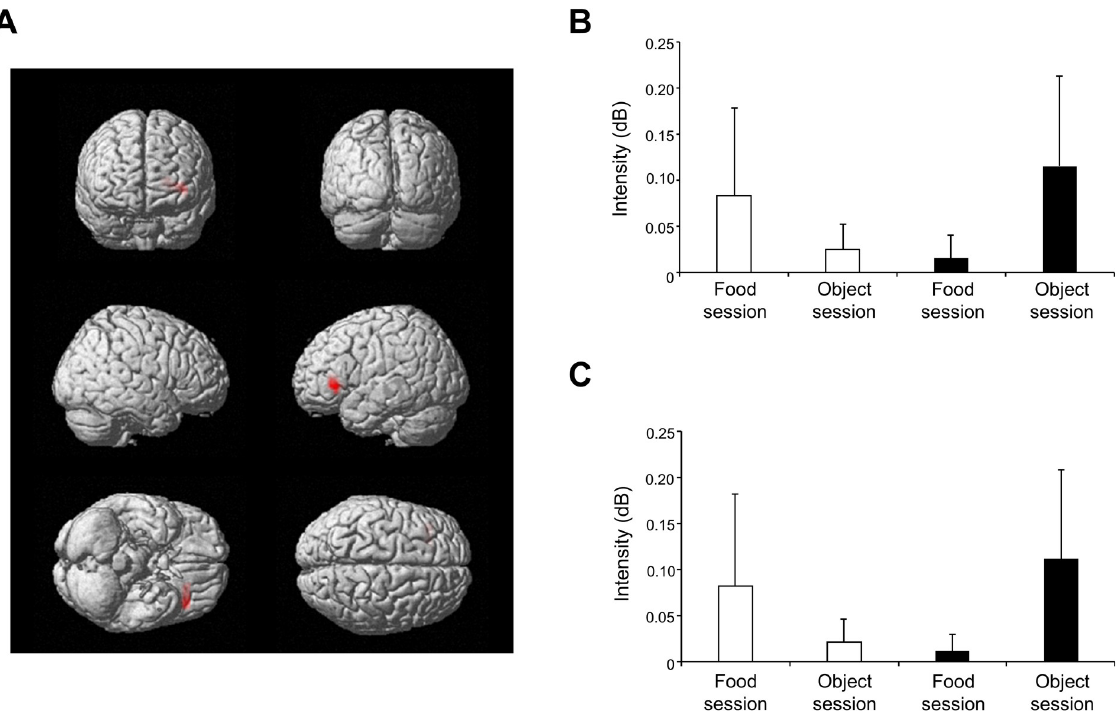
Fig 3. Neural activity corresponding to the interaction between sessions and conditions. (A) Statistical parametric map of the interaction observed between sessions (i.e., food or object) and conditions (i.e., visible or invisible) in the neural activity corresponding to the increase of high-gamma (80–200 Hz) oscillatory brain activity caused by viewing the pictures. The cluster in the left frontal region including Brodmann’s areas (BA) 45 and 47 was above the statistical threshold set at P = 0.00417 (family-wise error-corrected for multiple comparisons). (B) The levels of increases in high-gamma oscillatory brain activity observed in each session in left BA 45. Open and closed columns represent the values under the visible and invisible conditions, respectively. (C) The levels of increases in high-gamma oscillatory brain activity observed in each session in left BA 47. Open and closed columns represent the values under the visible and invisible conditions, respectively.